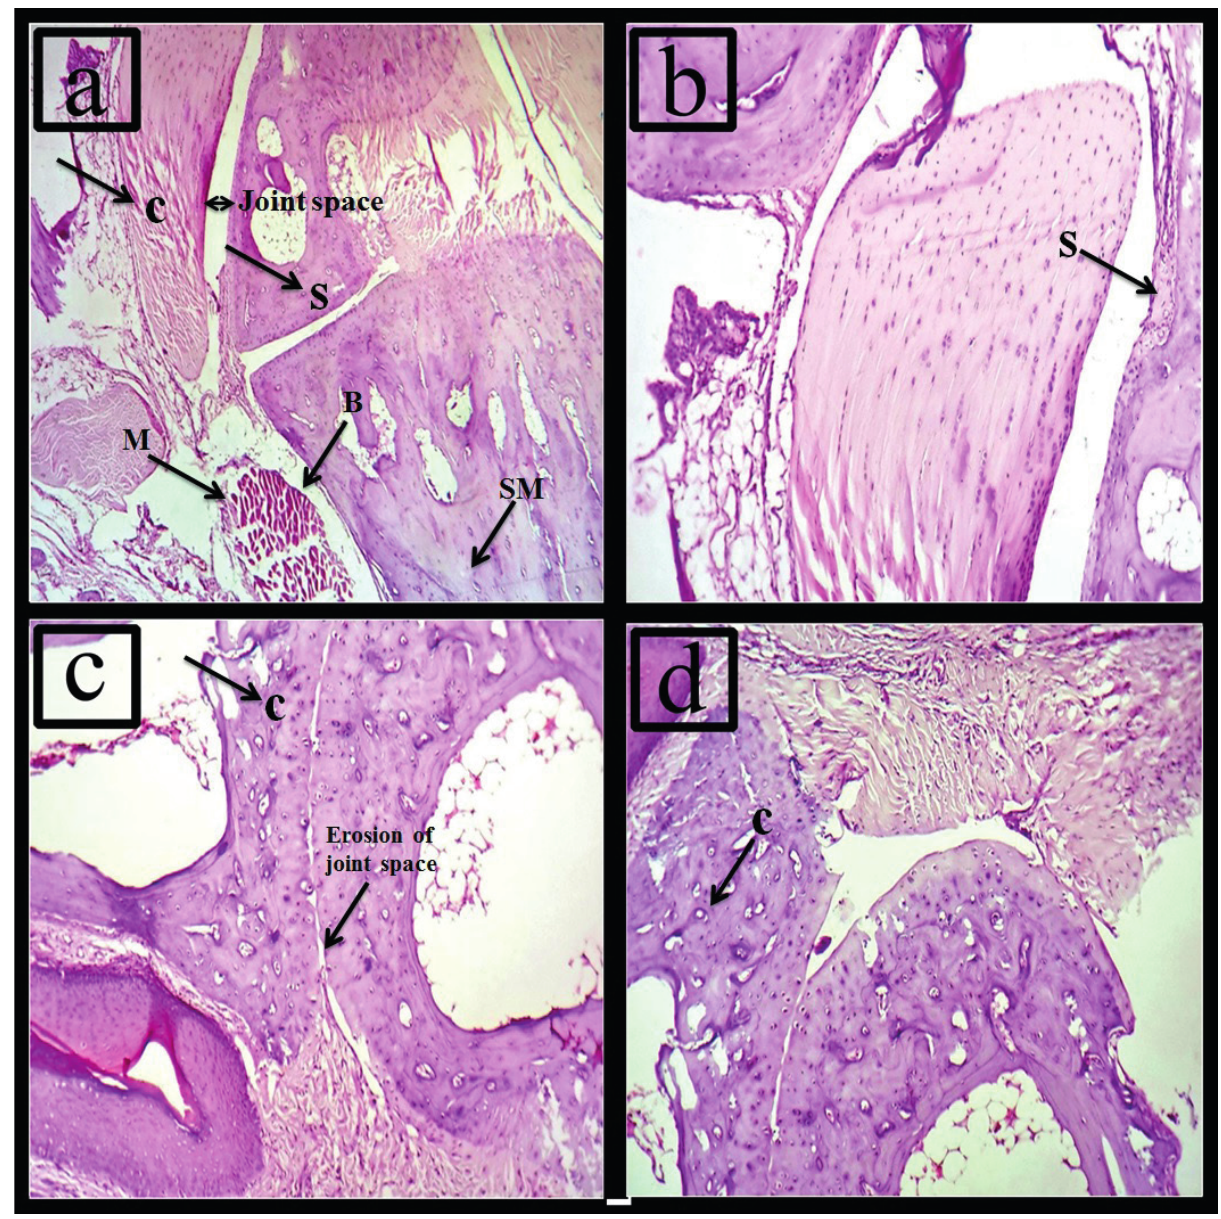
FIGURE 7 - Effect of β -carotene on paw histopathology of MSU crystal-induced arthritic rats Haematoxyli n and eosin staining: (7a) Normal appearing articular cartilage ( C ) and synovial tissue ( S ). Bone ( B ) and marrow ( M ) and adjacent skeletal muscles ( SM ) also appear normal (40X magnification); (7b) articular cartilage showing synovial hyperplasia ( S ) (100X magnification); (7c) Diminished joint space with erosion of the articular cartilage (100X magnification); (7d) Minimal inflammation in the adjacent joint capsule ( C ) (100X